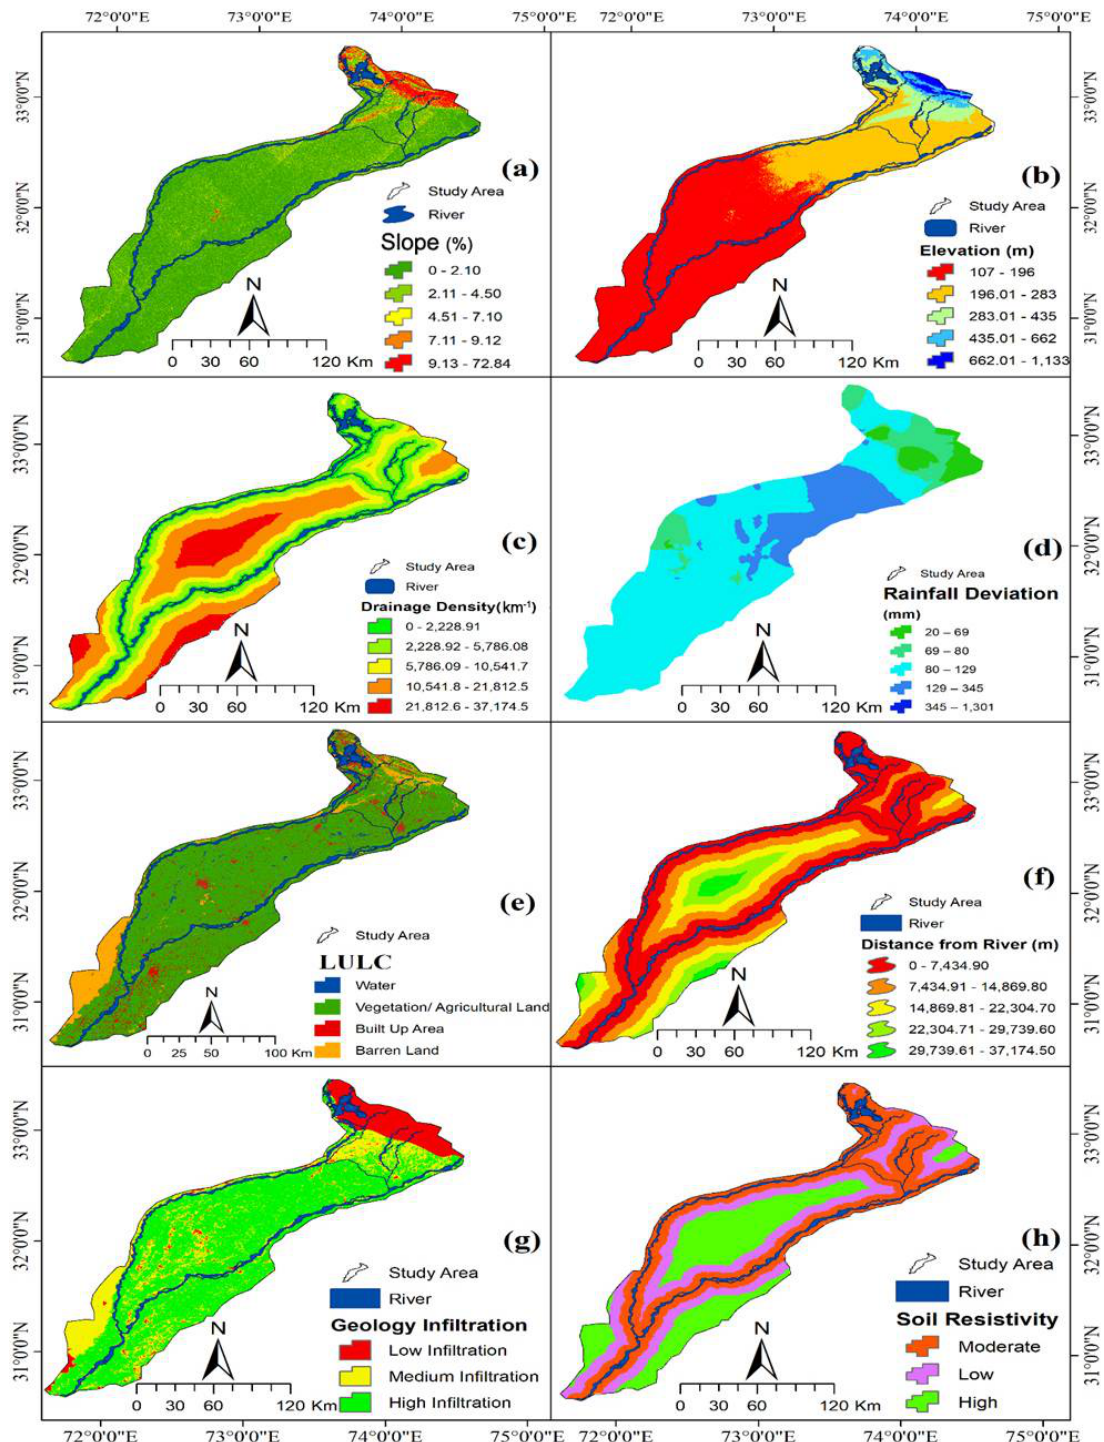
Figure 3. In this study, maps of flash flood conditioning variables were used: ( a ) slope, ( b ) elevation , ( c ) drainage density , ( d ) rainfall deviation, ( e ) LULC, ( f ) distance from the stream , ( g ) geology infil- ( c ) drainage density, ( d ) rainfall deviation, ( e ) LULC, ( f ) distance from the stream, ( g ) geology tration, and ( h ) soil resistivity. infiltration, and ( h ) soil